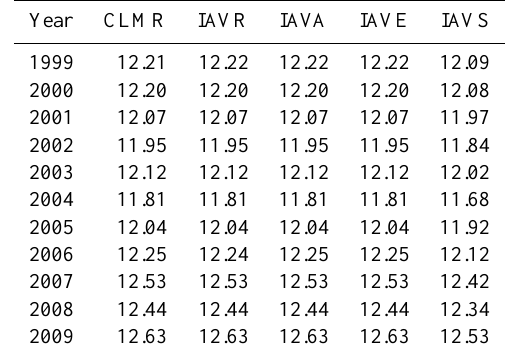
Table 8. Global sink strength (Tga − 1 N) for each of the sensitivity